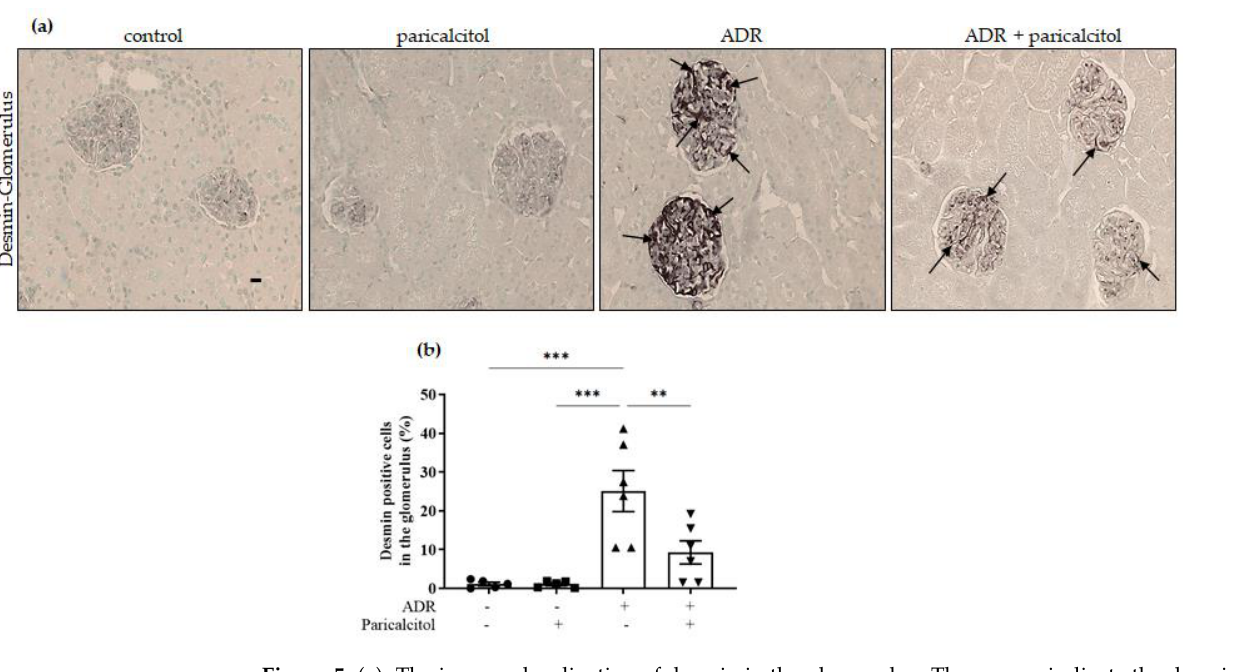
Figure 5. ( a ). The immunolocalization of desmin in the glomerulus. The arrows indicate the desmin-positive expression in the glomerulus. ( b ). Percentual of desmin-positive in the glomerulus from the control (dots), paricalcitol (squares), ADR (up triangles), and ADR + paricalcitol (down triangles) groups. Immunohistochemical data are expressed as the mean ± SEM. Scale bar = 20 µ m, n = 5 – 6 for each group. ** p < 0.01; *** p < 0.001.